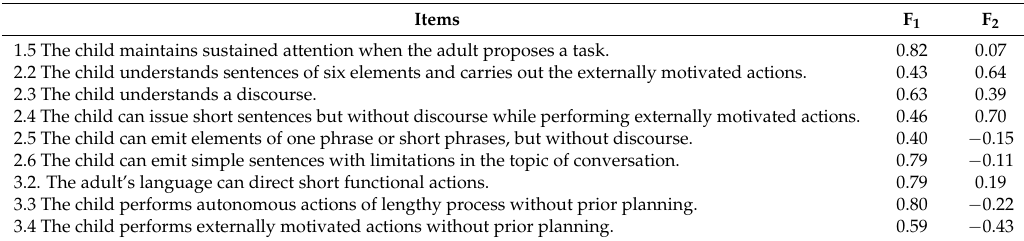
Table 3. Factors and Factor Loadings of the SMPMS Items in each Factor. Items F 1 F 2